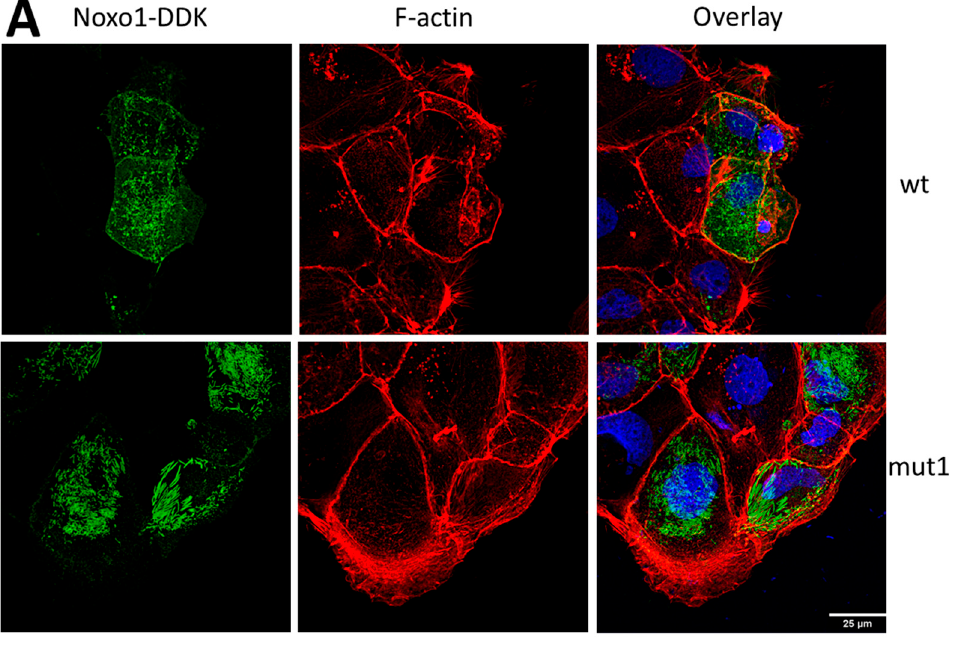
Figure 10. Immunofluorescence Noxo1 with F-actin or microtubules in Caco-2 transfected with wt Noxo1- or mut1 Noxo1-DDK. ( A ) Immunofluorescence of Noxo1-DDK and F-actin. Wt-Noxo1 and mut1-Noxo1 (green, upper and lower left panel), F-actin (red, middle panel), and overlay corre- sponding to Noxo1-DDK/F-actin/nucleus (using DAPI) (left panel). ( B ) Immunofluorescence of Noxo1-DDK and microtubules. Wt-Noxo1 and mut1-Noxo1 (green, upper and lower left panel), microtubules (red, middle panel), and overlay corresponding to Noxo1-DDK/microtubules /nucleus (using DAPI) (left panel). Scale bar in all panels: 25 µm. There is no particular colocalization of Noxo1 with F-actin except for a few peripheral membrane areas for either the wt or mut1 form of Noxo1 (Figure 10A). This rather un- common colocalization is compatible with the regulation of Nox and actin by Rho- GTPases in membrane signaling hubs. Microtubule organization in cells transfected with